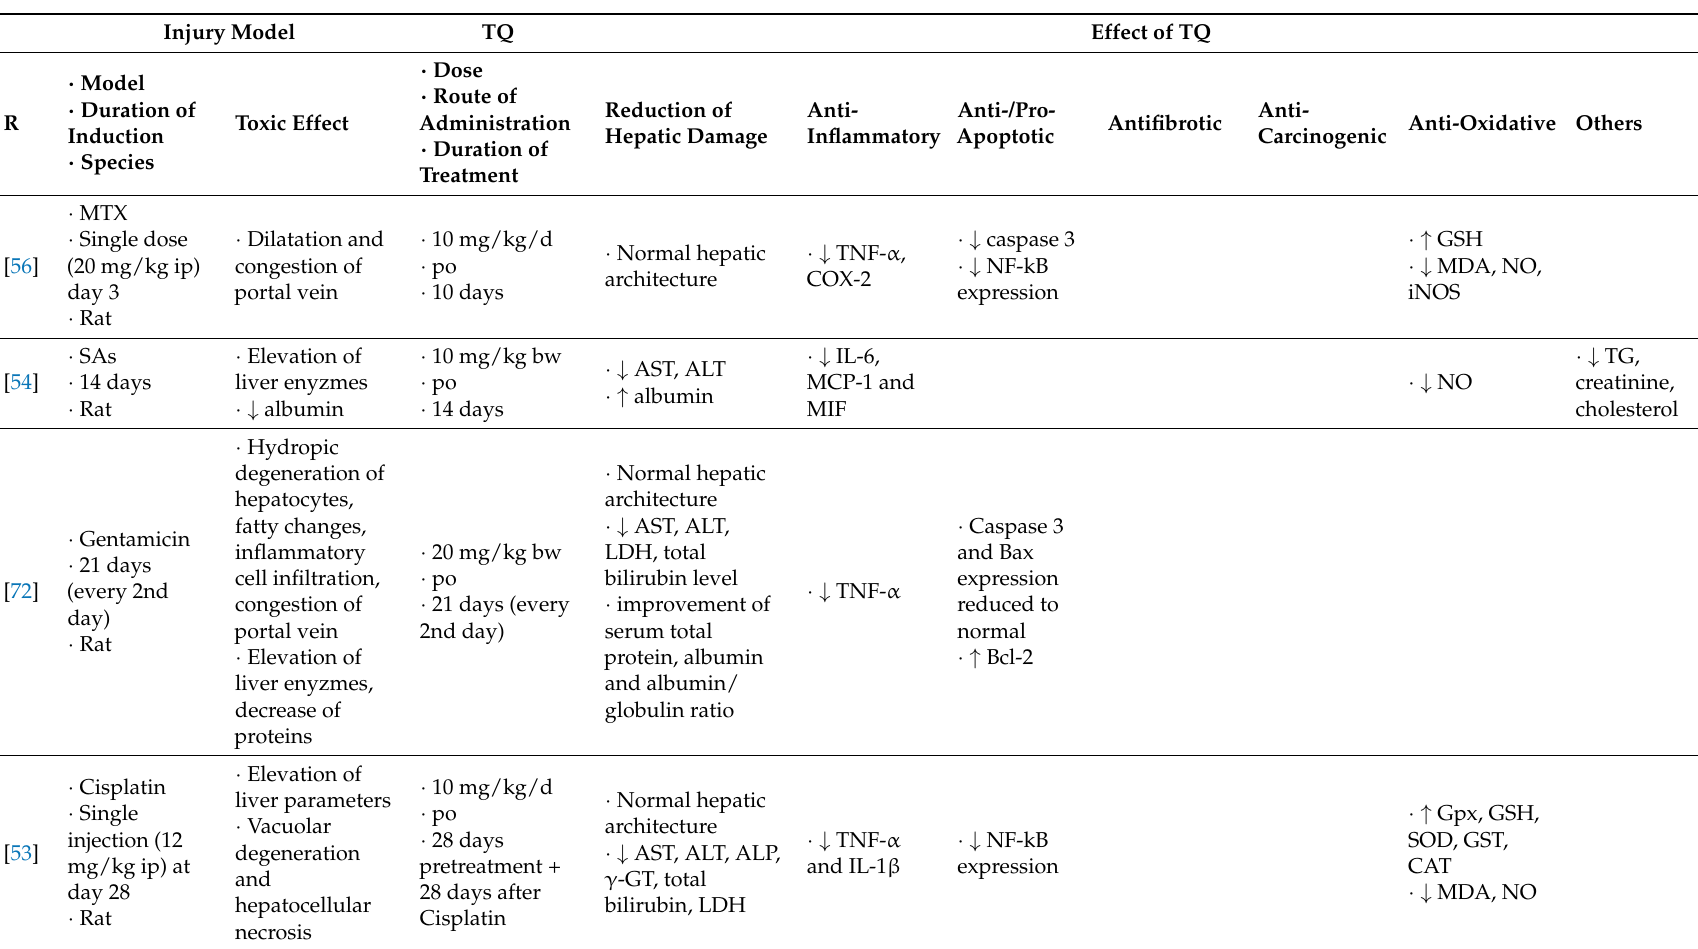
Table 4. Effects on liver injury caused by